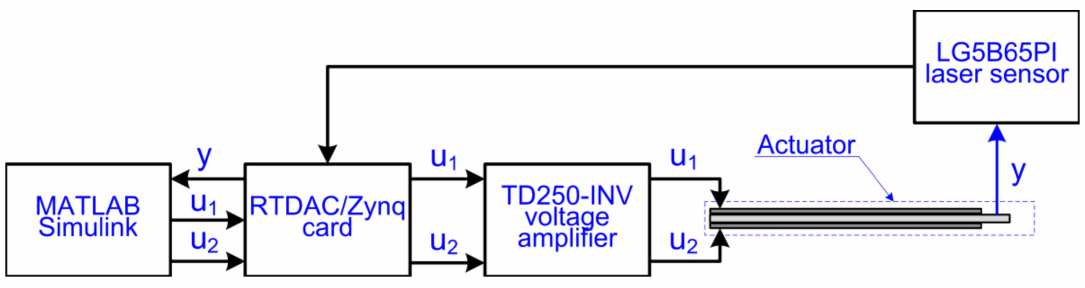
Figure 4. Schema of control system in laboratory